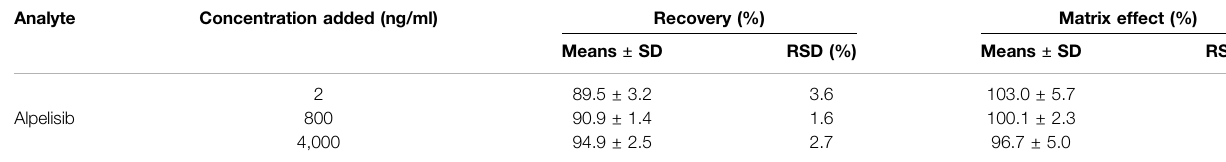
TABLE 3 | Recovery and matrix effect of alpelisib in rat plasma ( n (cid:1) 6). Analyte Concentration added (ng/ml)